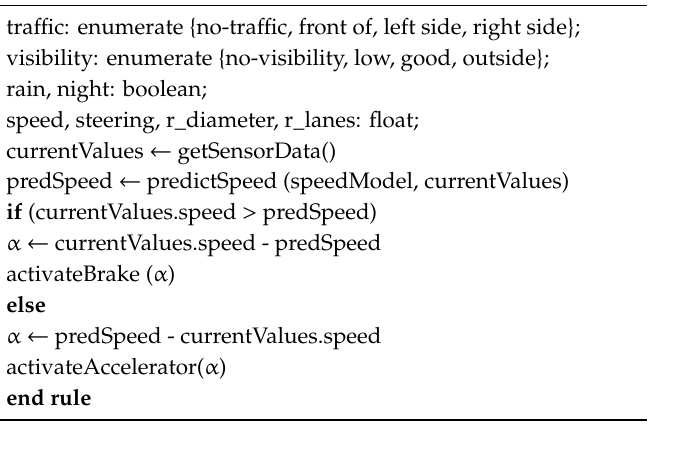
Algorithm 1. Rule for Speed Adjustment.